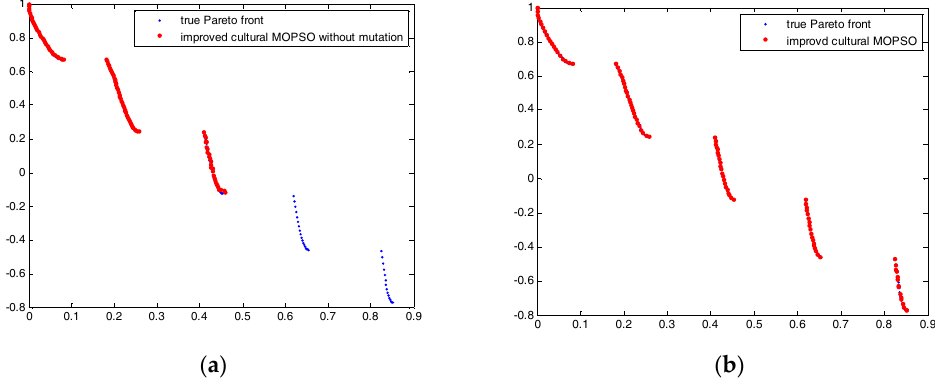
Figure 9. Pareto fronts for ZDT3: ( a ) the Pareto fronts obtained without using the mutation operator; ( b ) the Pareto fronts obtained using the mutation operator.